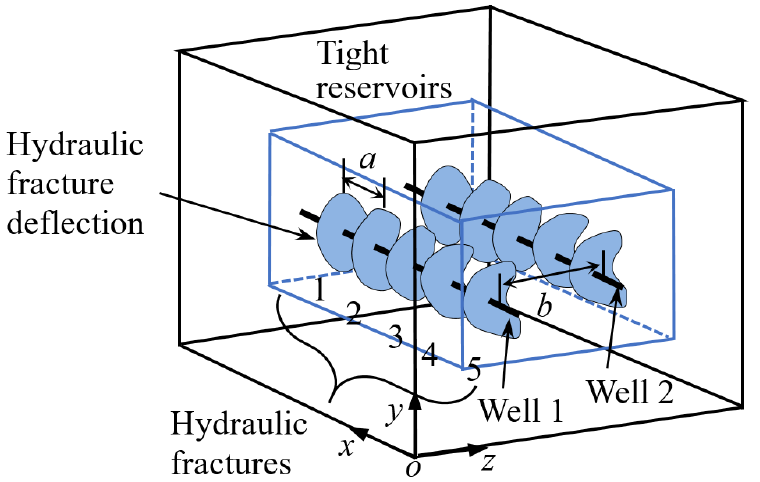
Figure 1. Schematic of unstable dynamic propagation and deflection of multiple hydraulic fractures in multi-well hydrofracturing ( a : perforation cluster spacing, b : well spacing).